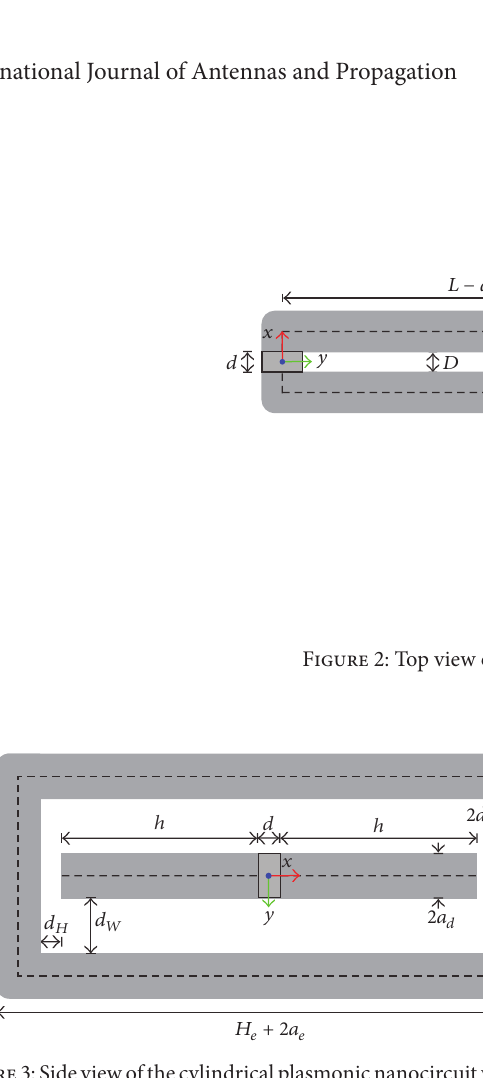
Figure3:Sideviewofthecylindricalplasmonicnanocircuitwithout